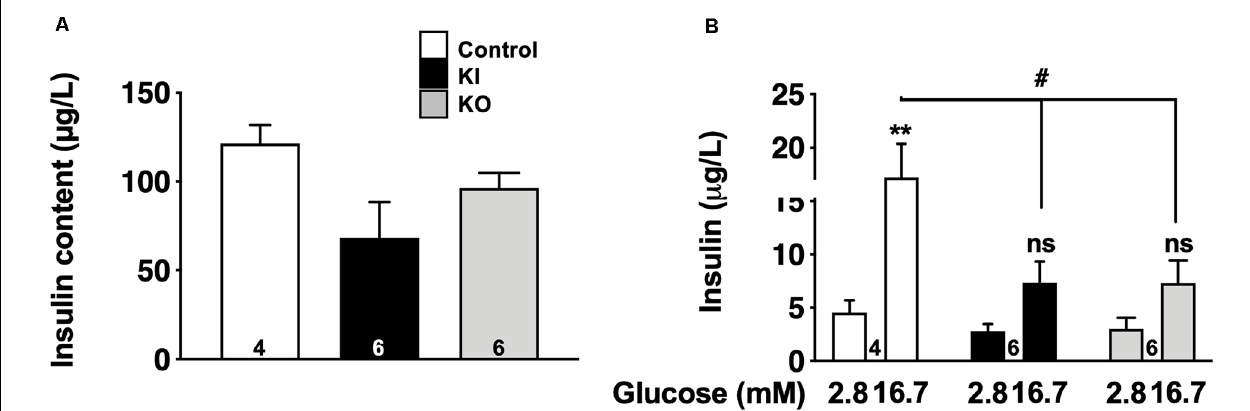
FIGURE 6 | Glucose-stimulated insulin secretion (GSIS) on islets isolated from tau knock-in and knock-out mice. (A) Insulin content ( µ g/L) from isolated islets ( N = 4–6 mice/group; NS using Kruskal Wallis test). (B) Insulin secretion from control, tau KI and tau KO islets stimulated with low (2.8 mM) and high (16.7 mM) glucose for 1 h ( N = 4–6 mice/group; Two-Way ANOVA; F (5,26) = 7.544 p < 0.001; Tukey’s post hoc test ** p < 0.01, # p < 0.05 vs. 2.8 mM). WT, tau KI, and tau KO are indicated as open bars, black bars and gray bars, respectively. Mice were 5-month-old. ns, non